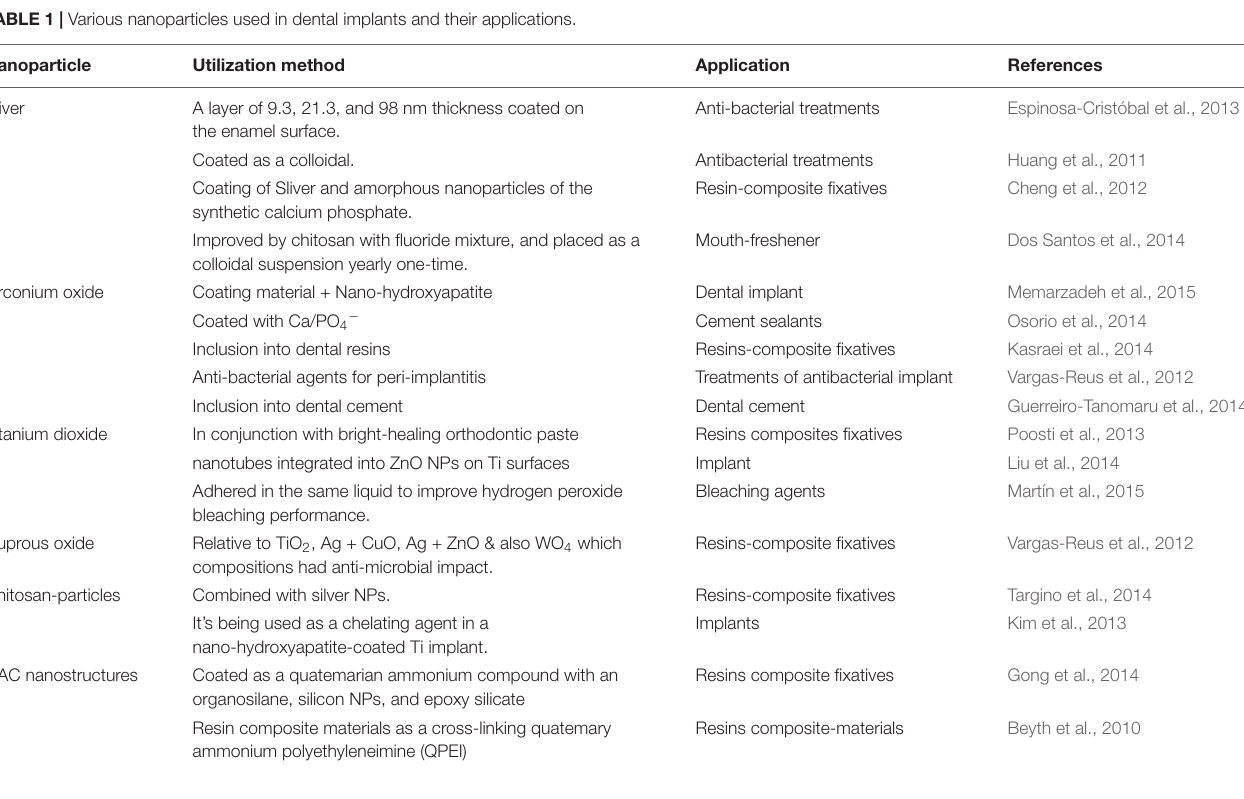
TABLE 1 | Various nanoparticles used in dental implants and their